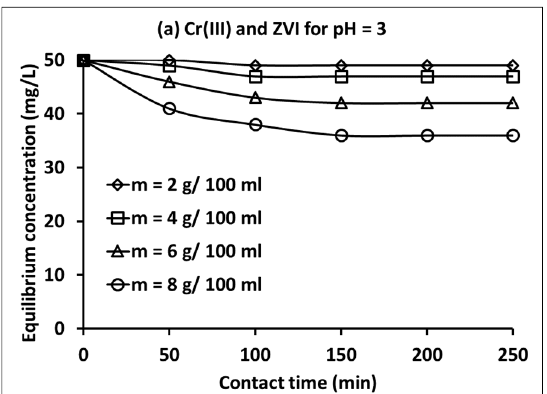
Fig. 1. Sorption of Cr(III) onto ZVAI at different values of